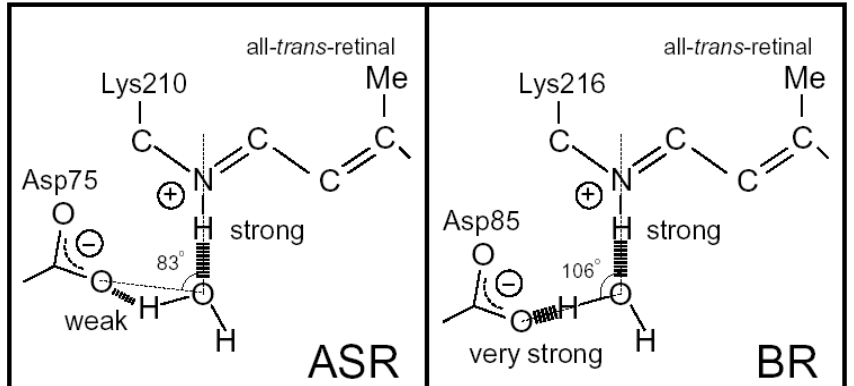
Figure 13. Schematic drawing of hydrogen bonds of the water molecule locating between the protonated Schiff base and its counterion. A part of all- trans retinal is depicted,  -ionon ring and ethylenic part from C6 to C12 are omitted. The numbers are the angle of the N-O-O atoms derived from the crystal structures of ASR and BR (PDB entries are 1XIO and 1C3W, respectively). Hydrogen bonds are indicated by the dashed lines with their strength. This figure is reprinted with permission from Furutani et al. [20]. Copyright 2005 American Chemical